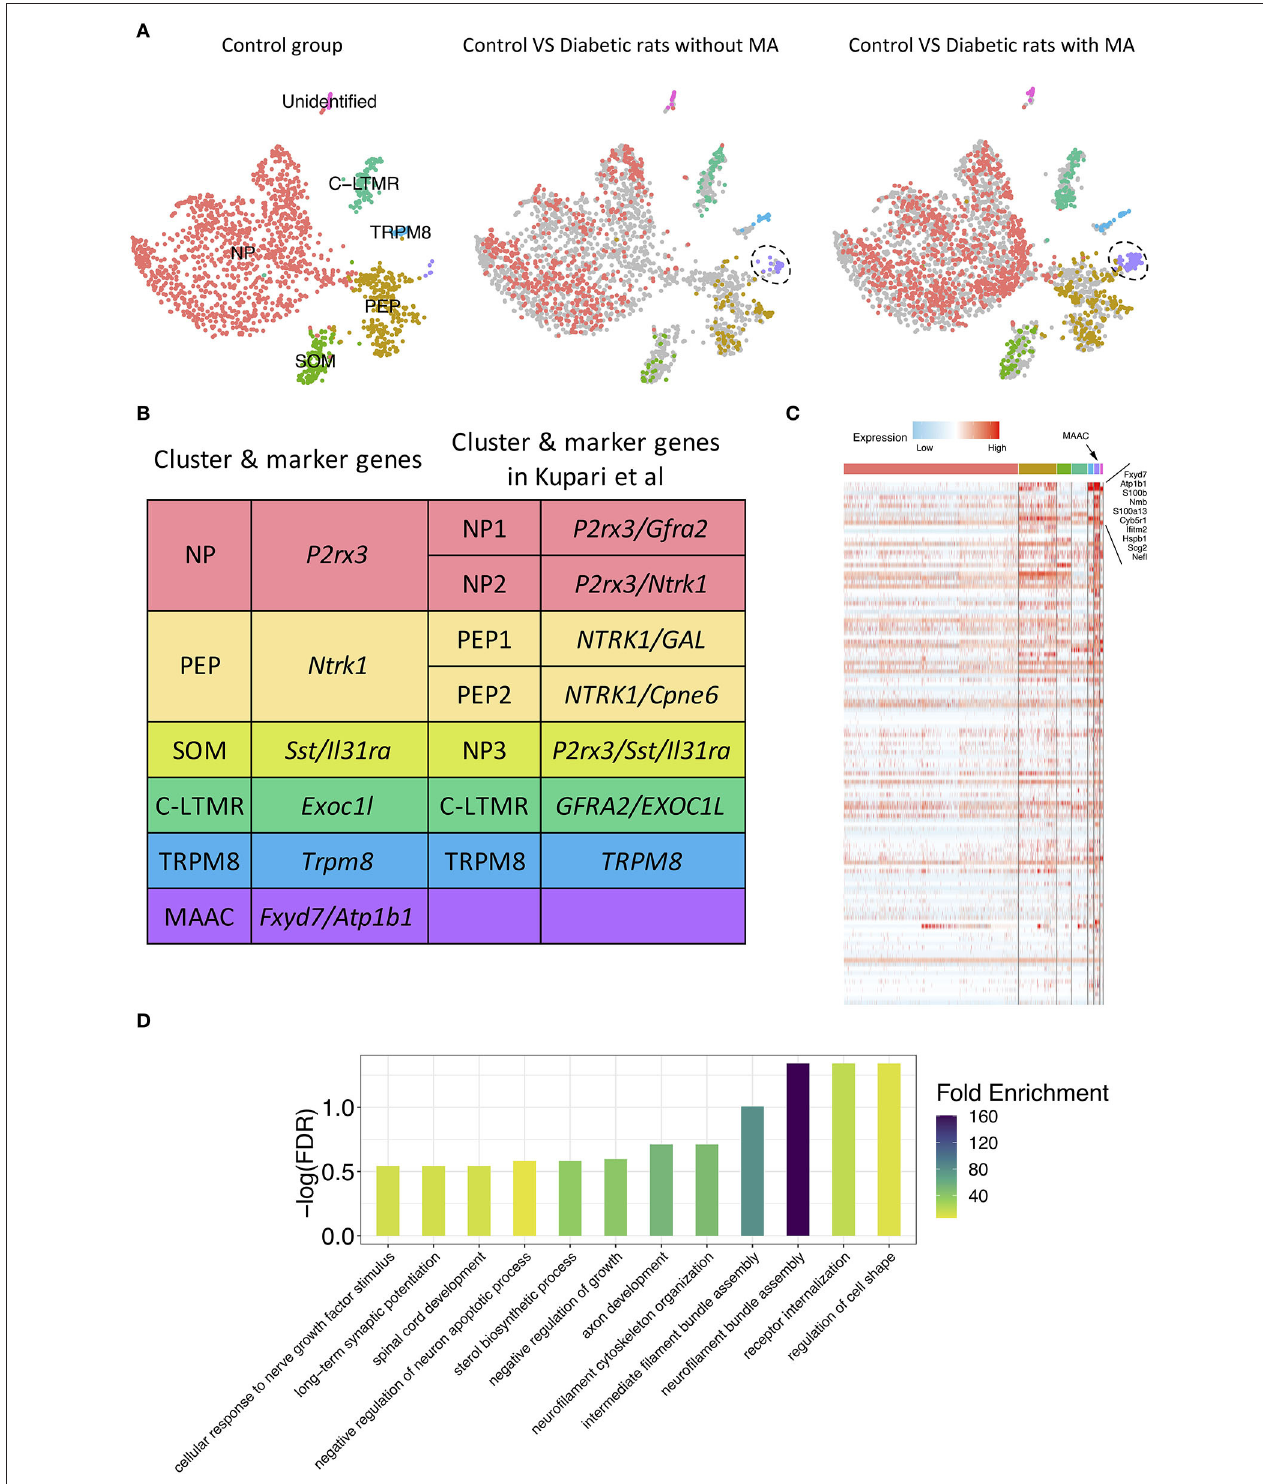
FIGURE 2 | Novel neuron cluster mechanical allodynia-associated cluster (MAAC) appeared in the development of PDPN. (A) t-SNE plot shows somatosensory neuron clusters in control versus in diabetic rats without or with mechanical allodynia (MA). The dots in the control group are grayed out when they are compared with the dots in the other two groups. Dots, individual cells; colors, neuron clusters. (B) Summary of neuron type classification in this work and previous study. (C) Heatmap shows the DEGs of MAAC. The genes with the largest fold difference are marked. Color, expression level. (D) Bar plot shows gene ontology (GO) terms of biological processes [false discovery rate (FDR) < 0.3] enriched for the DEGs of MAAC.